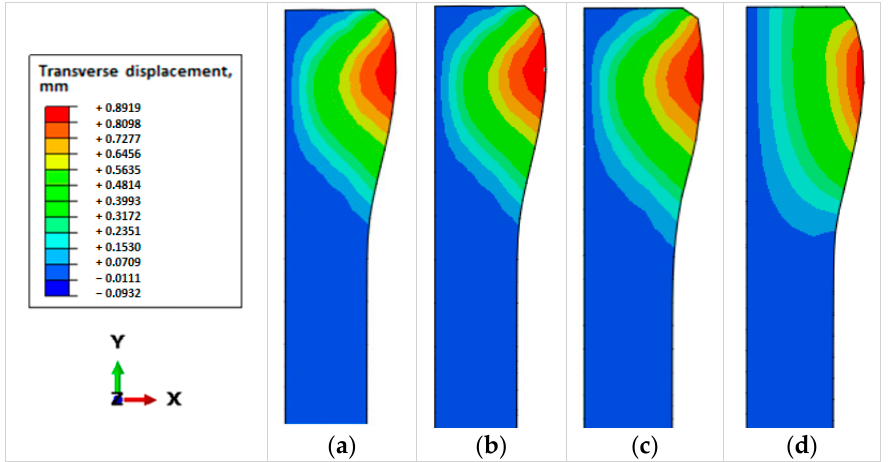
Figure 12. Transverse displacement distribution on the inspection plane: ( a ) large scale implicit transient model (control model); ( b ) short implicit transient model; ( c ) short explicit transient model; ( d ) Eulerian steady-state model.